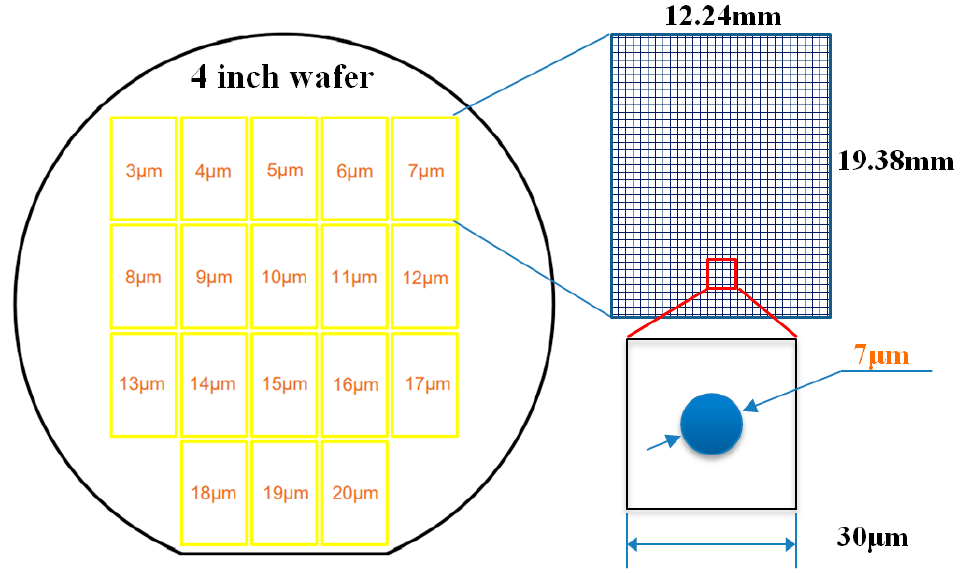
Figure 2. Micro-pillar layout on the 4-inch wafer with diameters from 3 to 20 m.